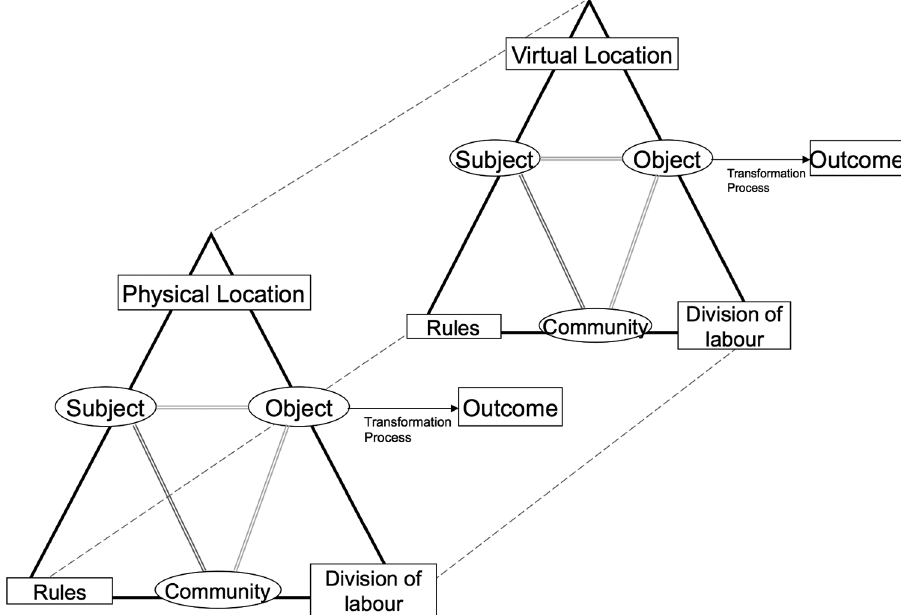
Figure 1. The physical and virtual contexts (adapted from Wali, Winters, and Oliver